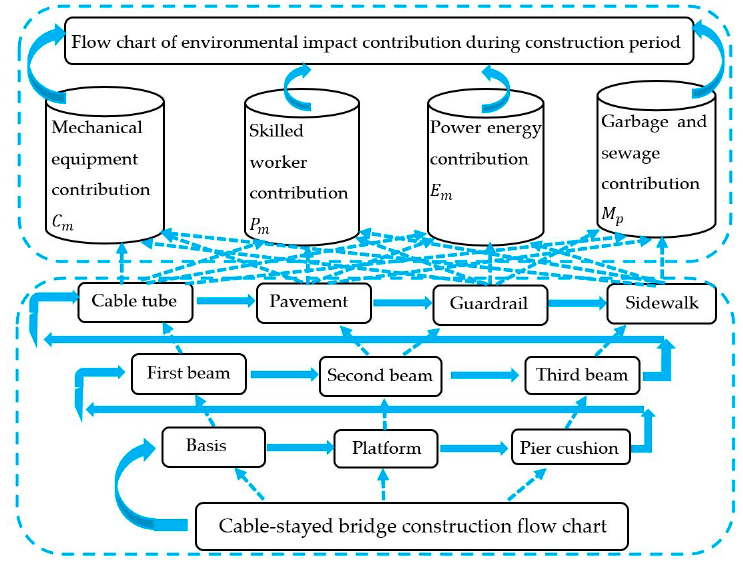
Figure 6. Schematic diagram of the process flow and environmental impact contribution during the construction.